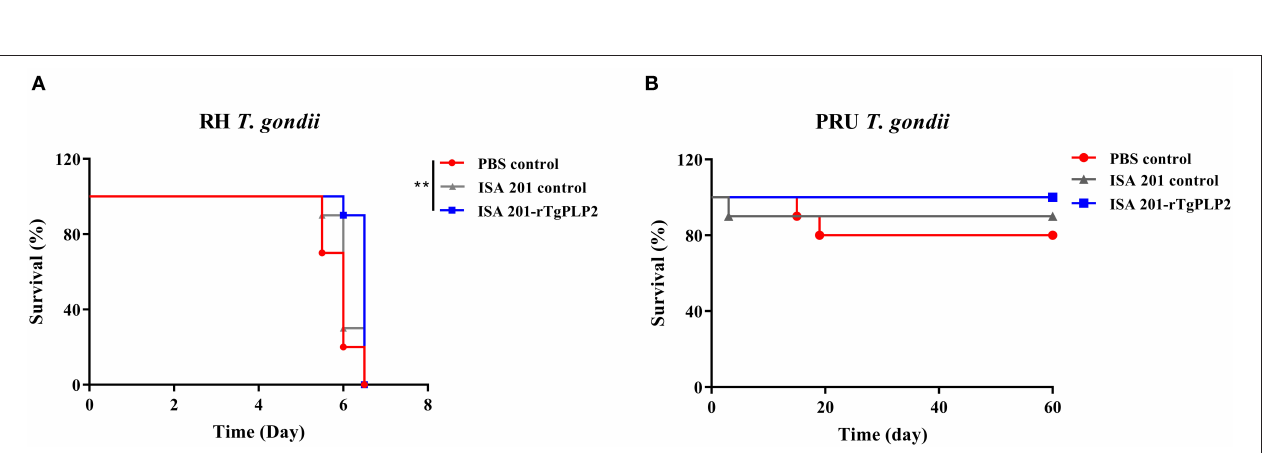
FIGURE 7 | Survival curves of mice infected with T. gondii RH strain (A) and PRU strain (B) . The survival of PRU strain challenged mice were monitored for 60 days. ** p < 0.01 compared with PBS controls.